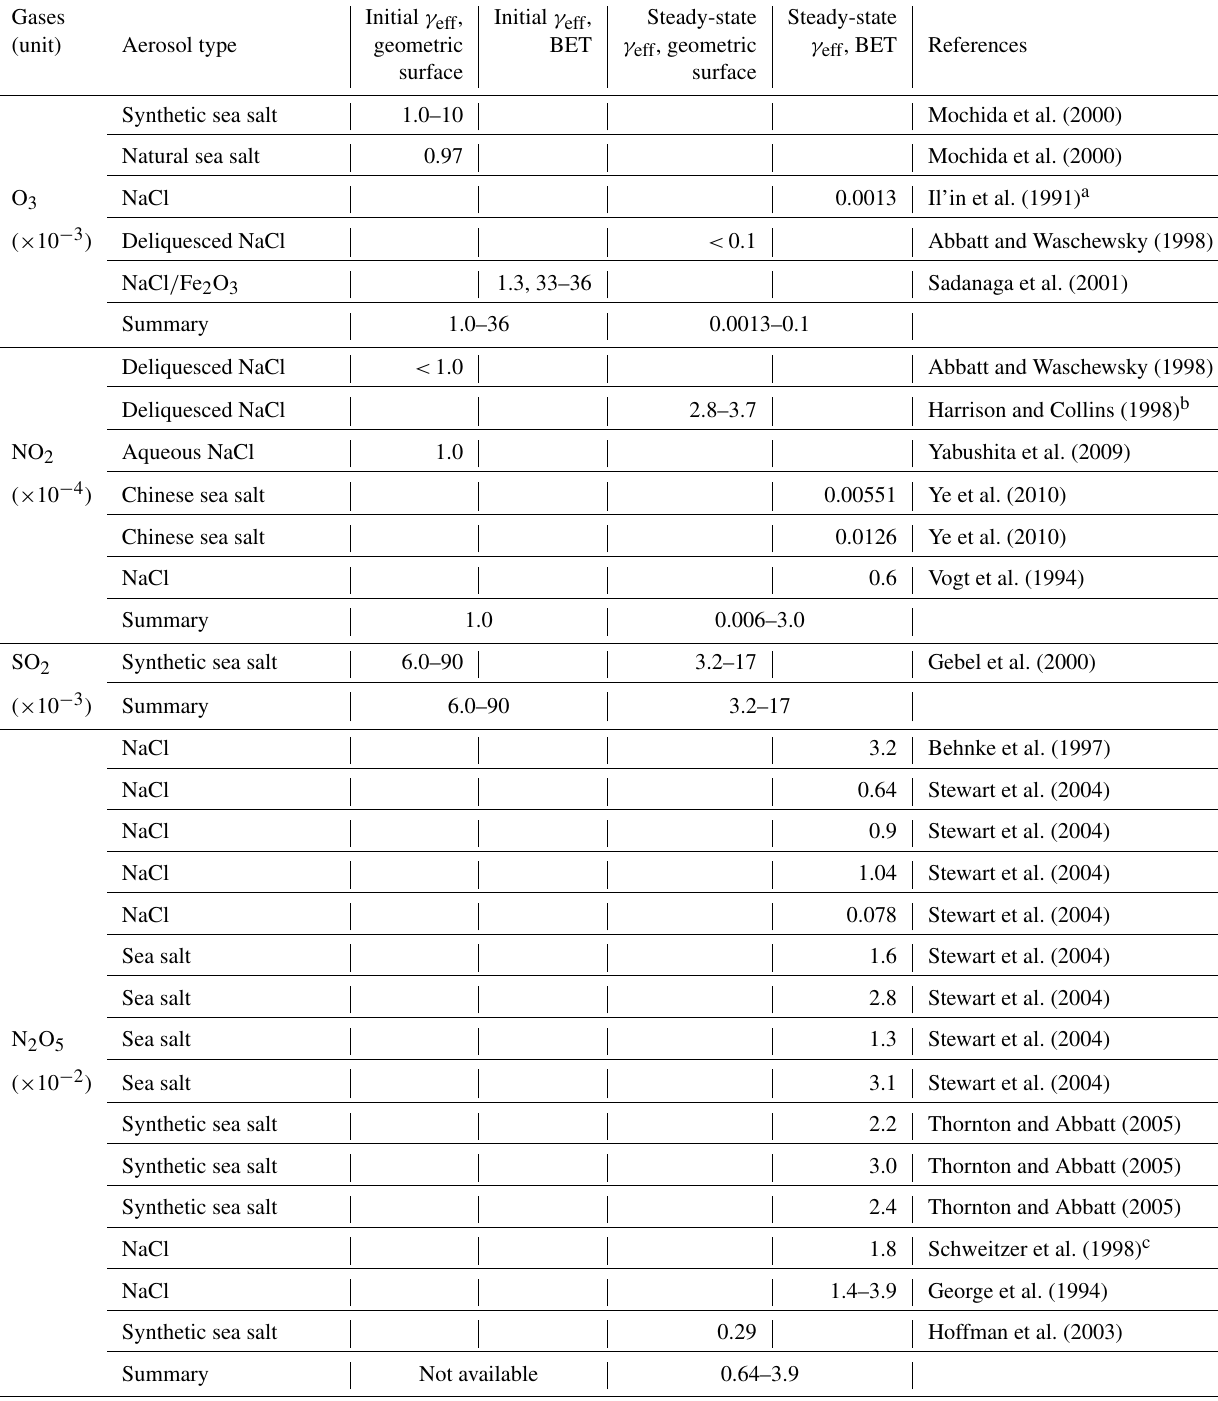
Table A4. Aerosol uptake coefficients ( γ eff ) for reactive gases on sea salt aerosols observed in laboratory experiments ( T = 298 ± 2K if not specified